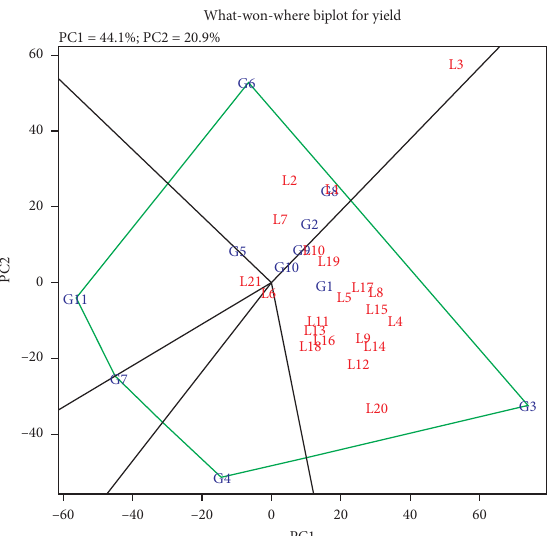
Figure 1: The “which-won-where” graph of the genotypic main effects plus genotype environment interaction (GGE) biplot for maize hybrids tested under multiple locations for rainy and dry seasons. The code of environments is given in Table 1. Code of genotypes is given in Table 2. PC, principal